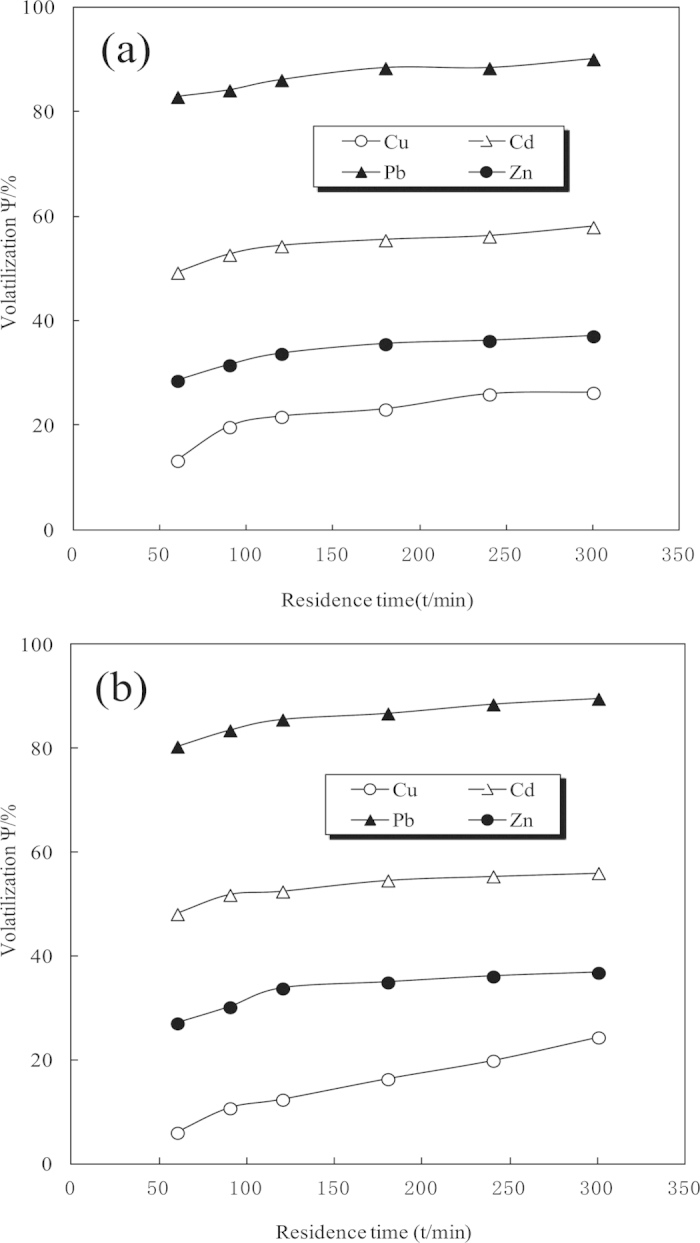
Volatilization characteristics of heavy metals in fly ash without chlorination agent at (a) 900 °C, (b) 1000 °C.